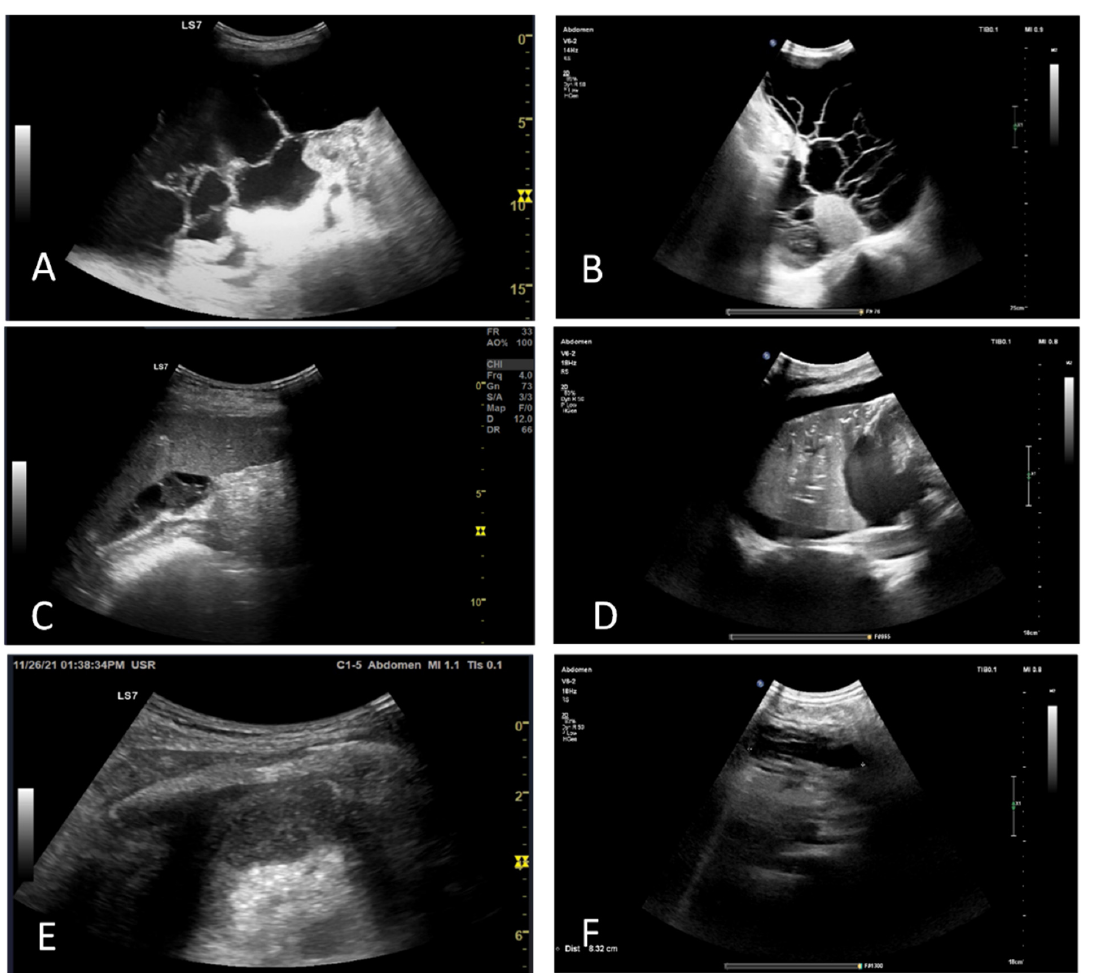
Figure 4. Abdominal and thoracic ultrasound in evolution. ( A , B ): Peritoneal effusion with septa. ( C ):Perisplenic cloasonated peritoneal effusion. ( D ): Pleural effusion of the inferior lung lobe, with air bronchograms. ( E , F ): Left subphrenic effusion, showing deep enhancement, suggestive of infection (abscess).